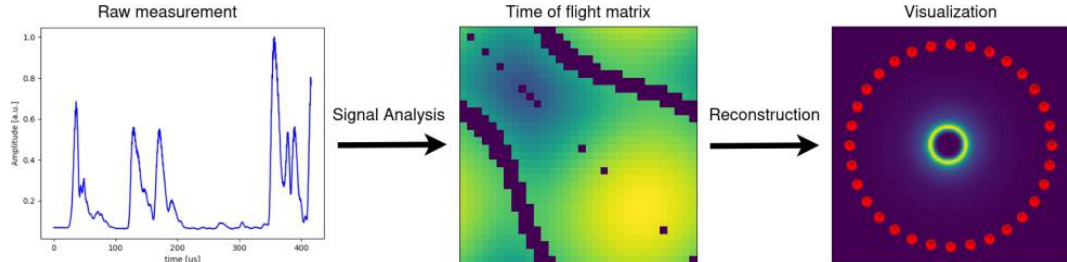
Figure 9. Two-stage reconstruction based on reflective ultrasonography. The graph on the left shows the signal converted to local variance. The graph in the middle is a heatmap showing the return times of the second wave packet. The graph on the right is an image reconstruction based on the SAT matrix.